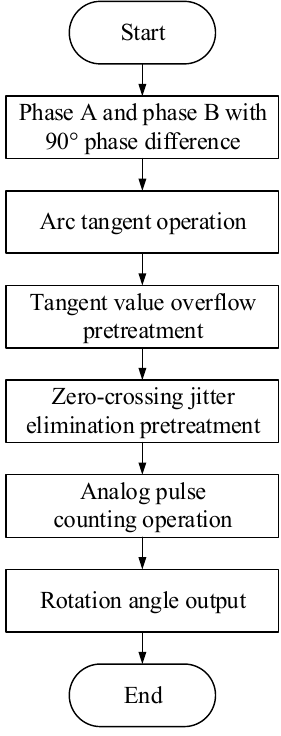
Figure 3. Technical process of the Analog Pulse Counter (APC) method.